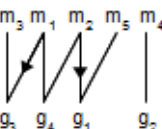
Figure 4. The graph of